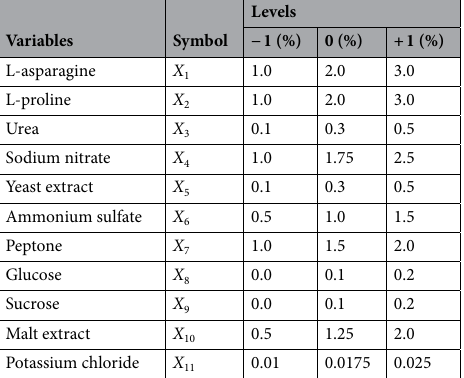
Table 5. Levels of the independent variables of the PBD experimental design to identify the influential factors on L-asparaginase production.